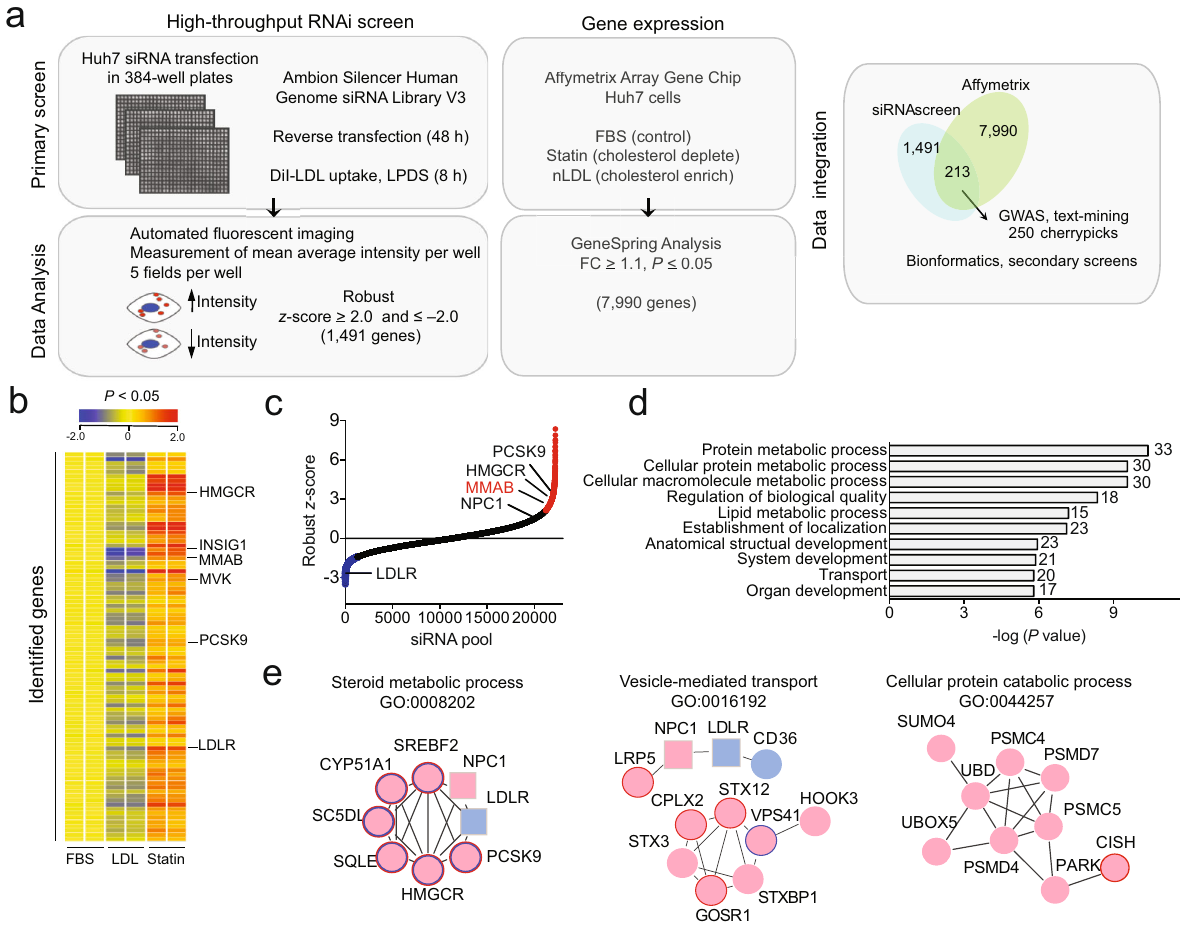
Fig. 1 Genome-wide RNAi screen reveals regulators of LDLR activity. a Outline of screening and bioinformatic procedures. b Gene expression analysis in Huh7 cells cultured in 10% fetal bovine serum (FBS, control), 120 µ g/ml native LDL (nLDL, cholesterol enriched) or 5 µ M statin (statin, cholesterol- depleted) for 24 h. Representative heatmap shows up- and downregulated genes (FC ≥ 1.1 in statin-treated cells compared to control; FC ≤ – 1.1 in